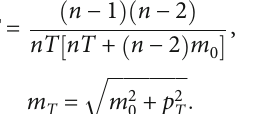
Table 1: Values of parameters and χ 2 /dof corresponding to the curves in Figures 1, 3, 5, 7, 11, 12, 13, 15, and 16.